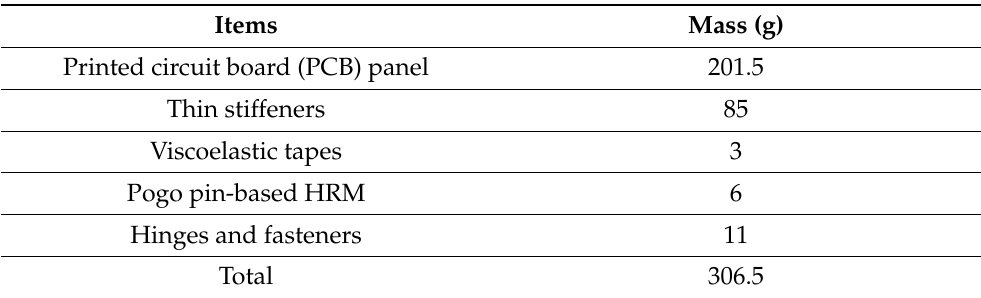
Table 3. Detailed mass budget of the proposed solar panel